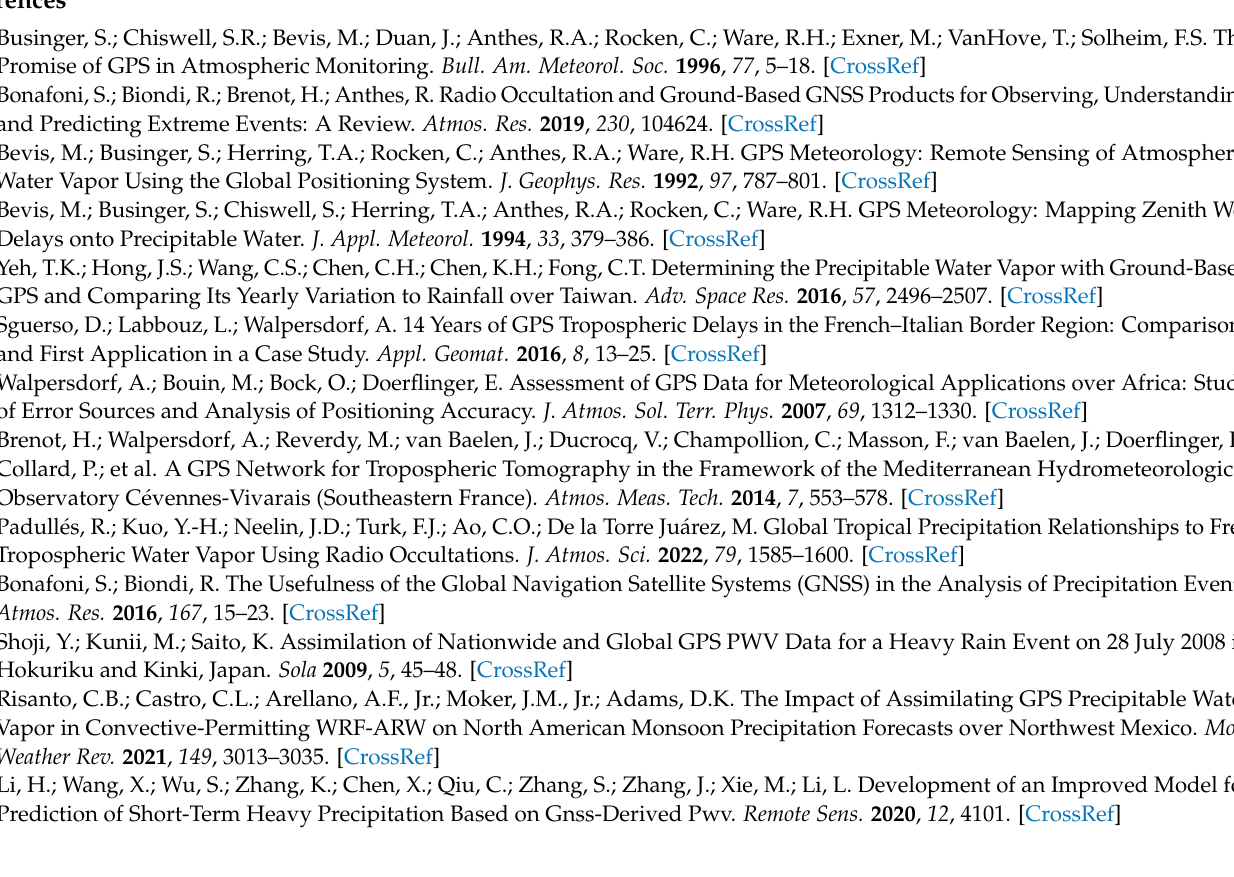
Figure A2. Wavelet Cross-Spectrum (XWT) and Wavelet Transform Coherence (WTC) of the stations for the year 2014 for the Coast, Andes Valley 1, Andes Valley 2, High Mountain and Amazon.